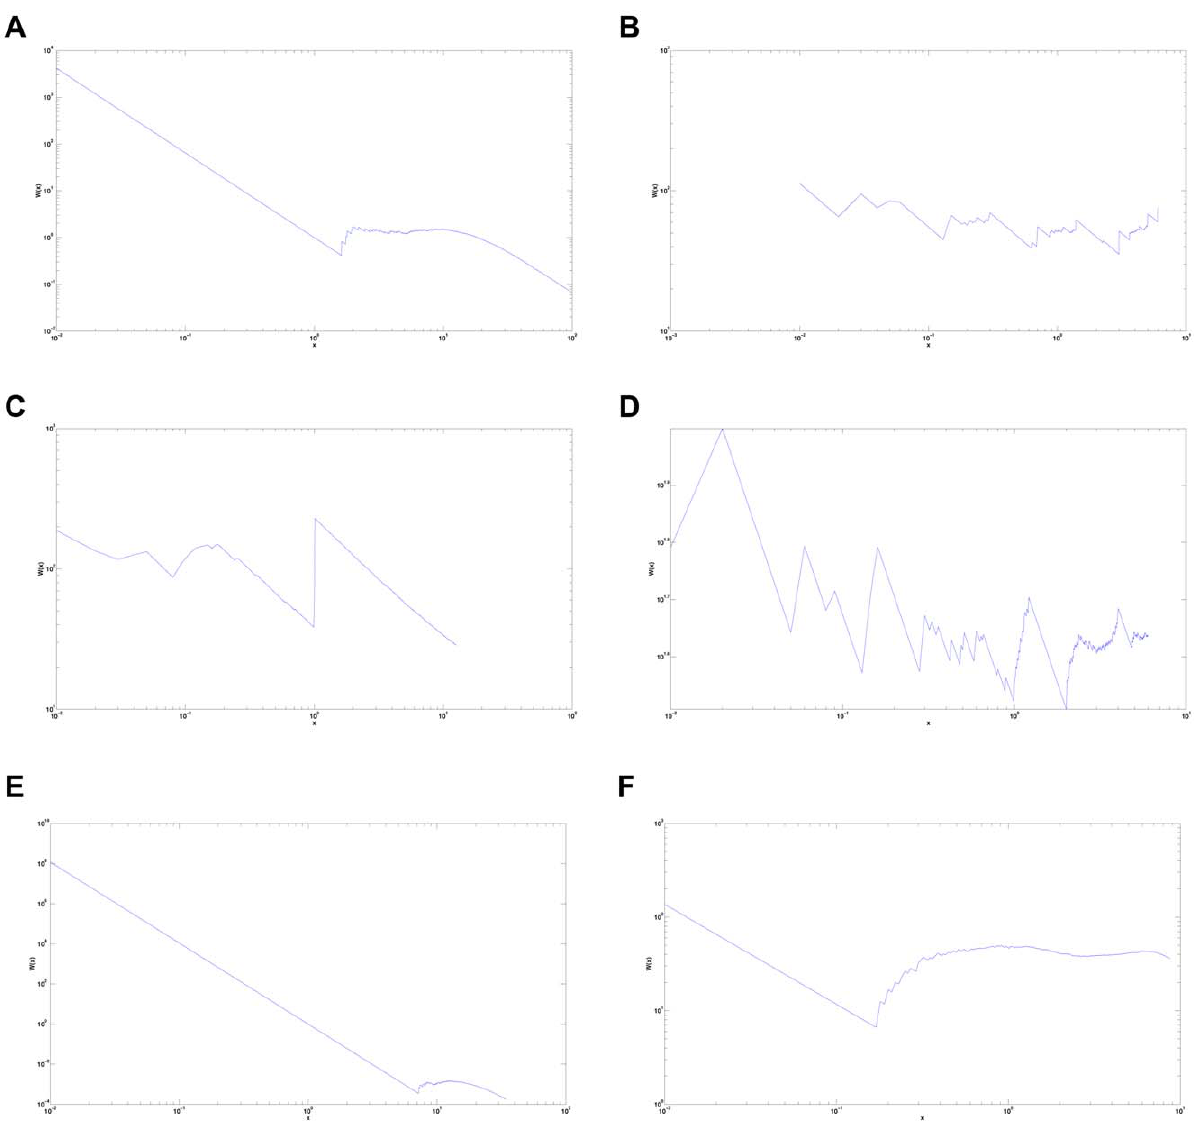
Figure 2. Weyl Ratios (a) C. elegans neural network (b) Sierpinski Gasket, Level 5 (c) Random Tree n ~ 279, m ~ 10 (d) Hexacarpet Level 3 (e) Random Network n ~ 279, p ~ 0 : 07 (f) Sierpinski Gasket Rewiring p ~ 0 : 15 .